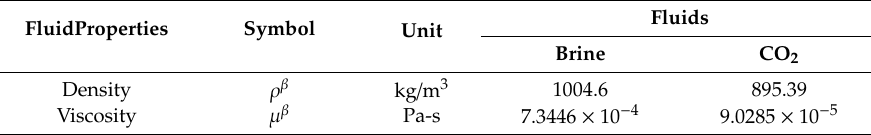
Table 7. Fluid properties (From NIST webbook NIST [46]).